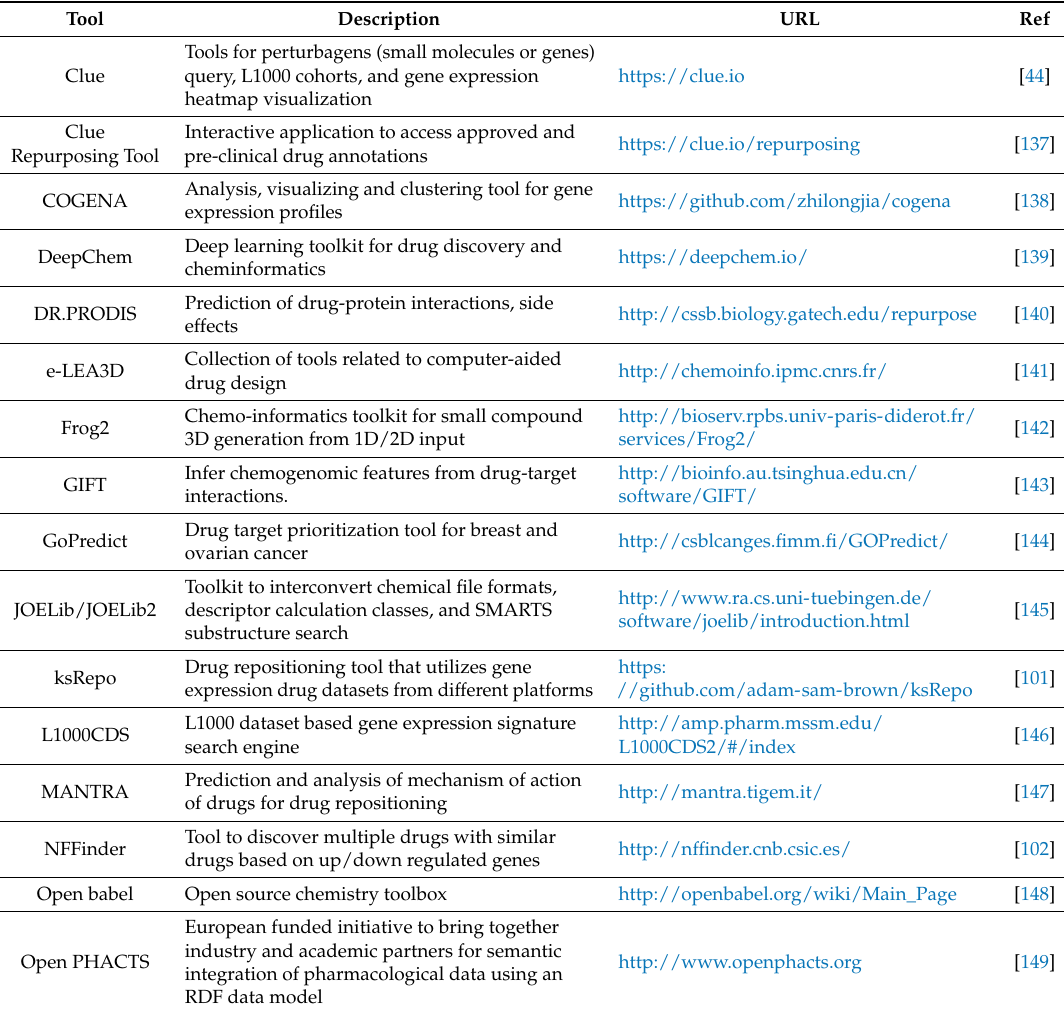
Table 5. Web-tools and open source